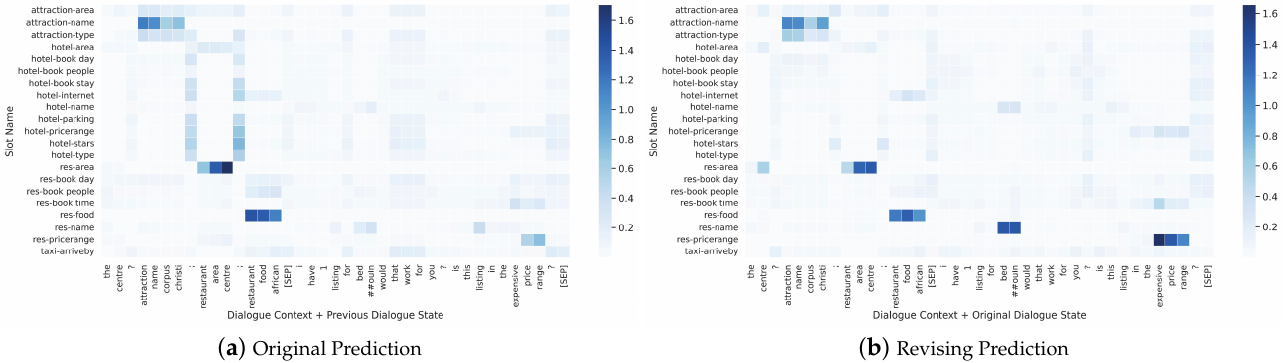
Figure 10. Visualization of the ( a ) original prediction and ( b ) revising prediction at turn four on an example of dialogue ID PMUL2279 (Figure 1) from MultiWOZ 2.1. Slots restaurant-name and restaurant-pricerange are new at turn turn, and the ground truth labels of restaurant-name and restaurant- pricerange are bedouin and expensive , respectively. In both figures, the ordinate is the slot name, the abscissa is the input sequence, and “ res ” represents “ restaurant ”. Due to space limitations, the ordinate and abscissa represent only a fraction of the entire